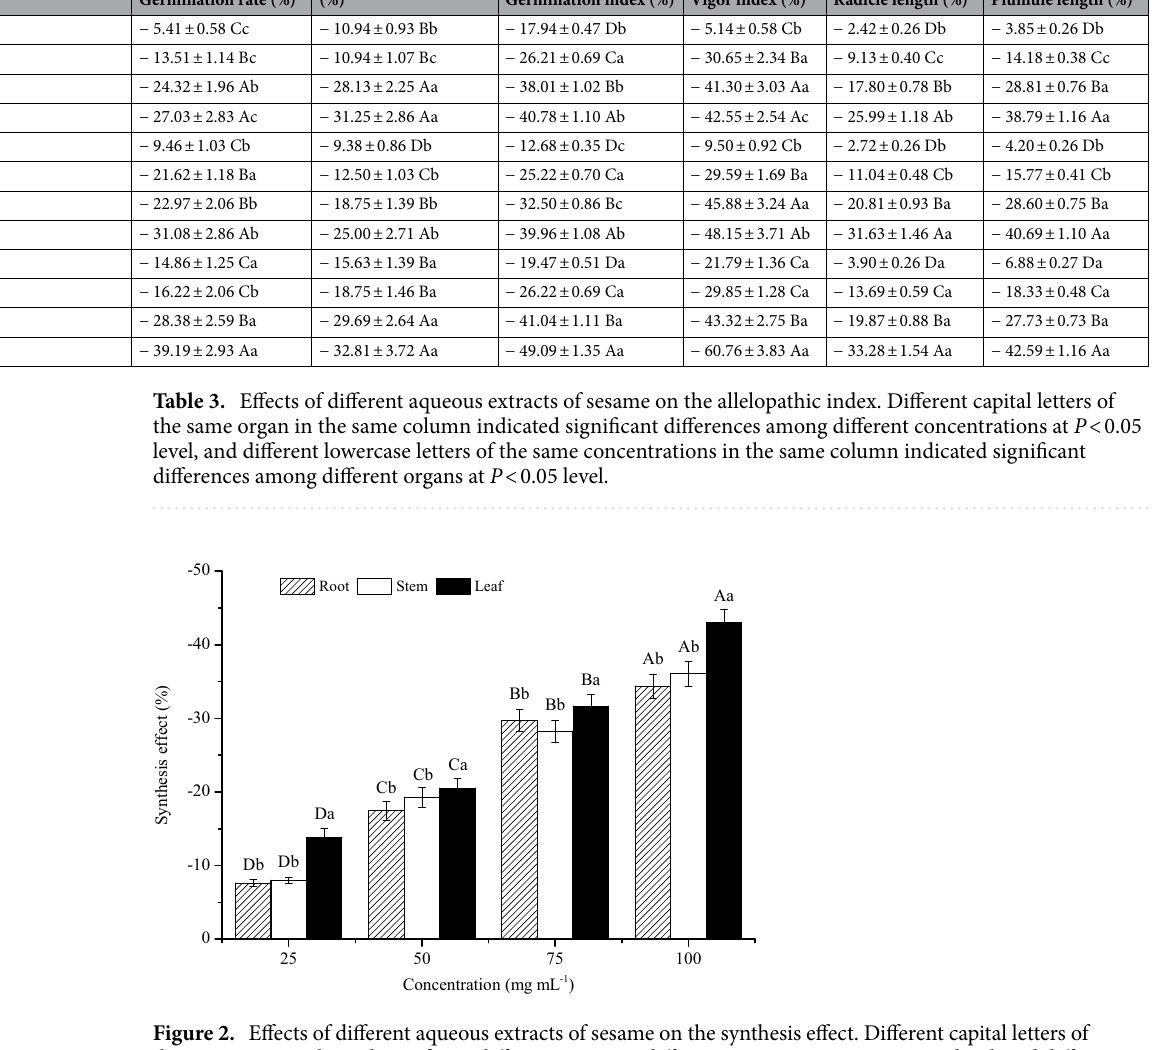
Figure 2. Effects of different aqueous extracts of sesame on the synthesis effect. Different capital letters of the same organ indicated significant differences among different concentrations at P < 0.05 level, and different lowercase letters of the same concentrations indicated significant differences among different organs at P < 0.05